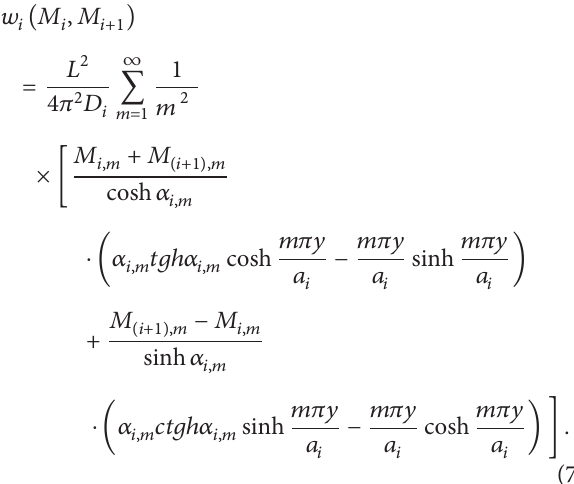
Figure 3: Box girder segment authoritative for the analysis of bear- ing